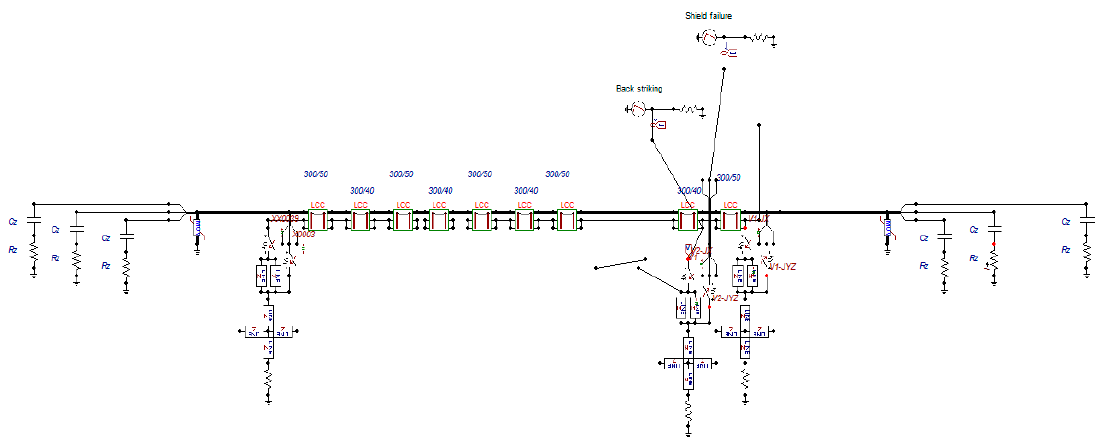
Figure 5. Lightning over-voltage simulation model.